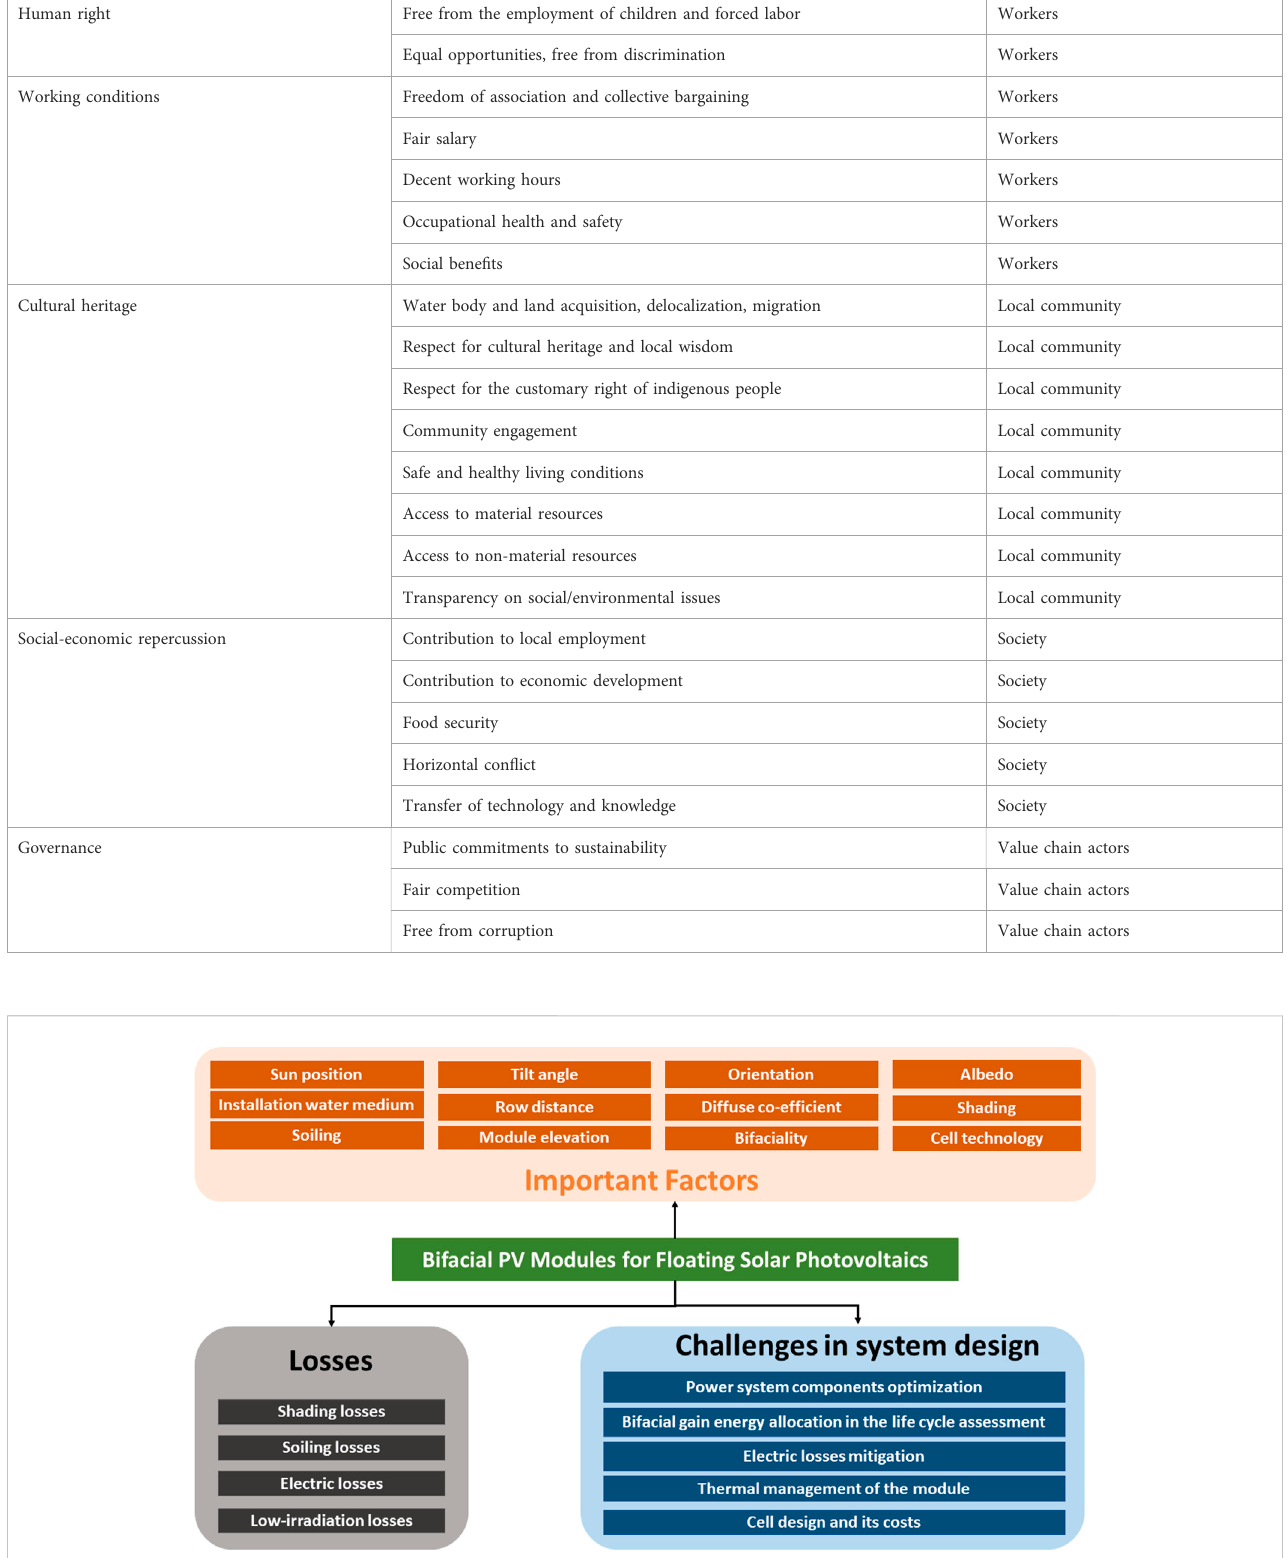
Frontiers in Energy